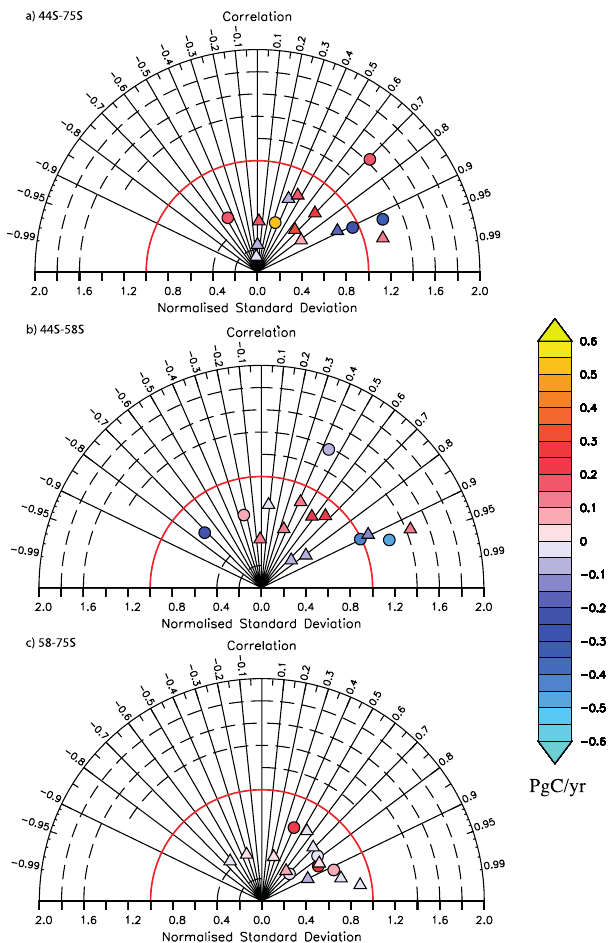
Fig. 8. Taylor diagram of the seasonal sea–air CO 2 flux assessed against the observations for ocean biogeochemical models (circles) and atmospheric inversion models (triangles). The upper panel represents the region 44–75 ◦ S; the middle panel the region 44–58 ◦ S; and the lower panel the region 58–75 ◦ S. The colours represent the difference between the total observed annual uptake and the models (see text for a comprehensive explanation). The annual mean differences (colour bar) are in PgCyr − 1 . Ocean biogeochemical models are represented as circles, while triangles represent atmospheric